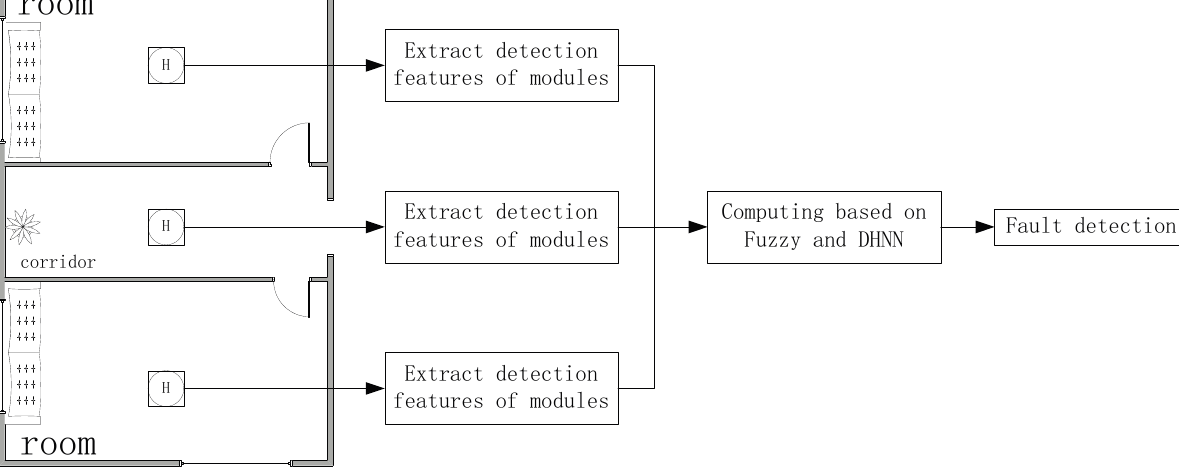
Figure 1. Flowchart of the proposed